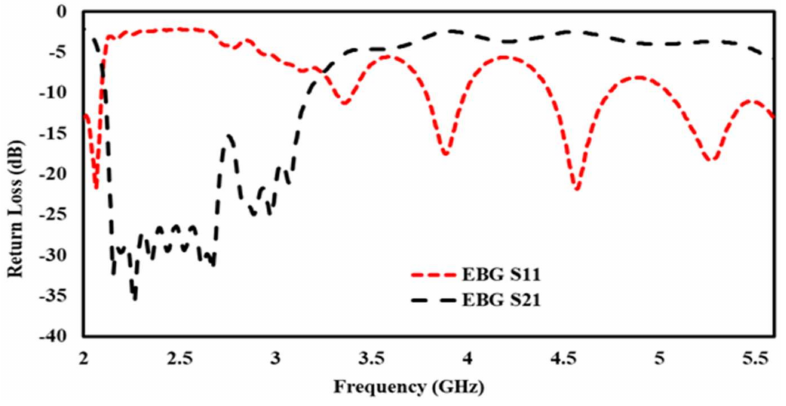
Figure 4. Simulated S11, S21 of EBG array.